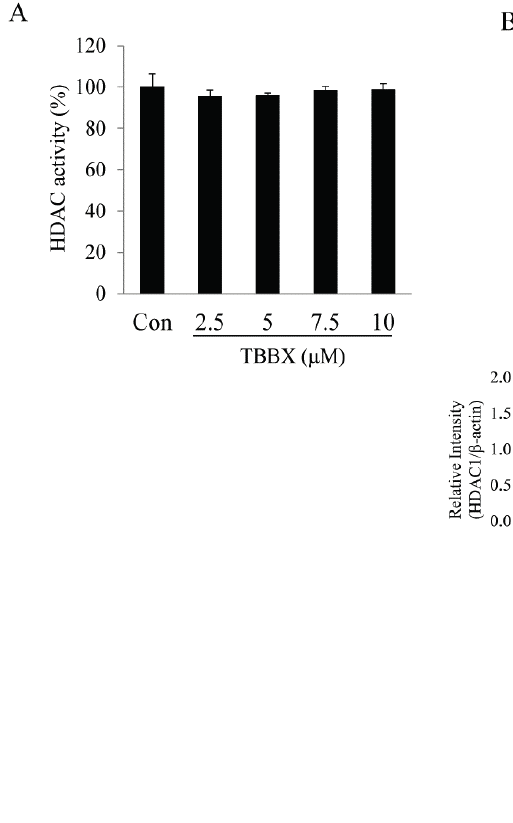
Figure 5. Effects of TBBX on the class I HDAC activity and protein expression in H1299 lung cancer cells. ( A ) Direct inhibition class I HDAC activity assay by TBBX was performed as described in Materials and Methods. ( B ) H1299 cells were treated with various dosage of TBBX (0, 2.5, 5, 7.5, and 10 μ M) for 24 h. After treatment, cells were antibodies. Data shown are representative of at least three independent